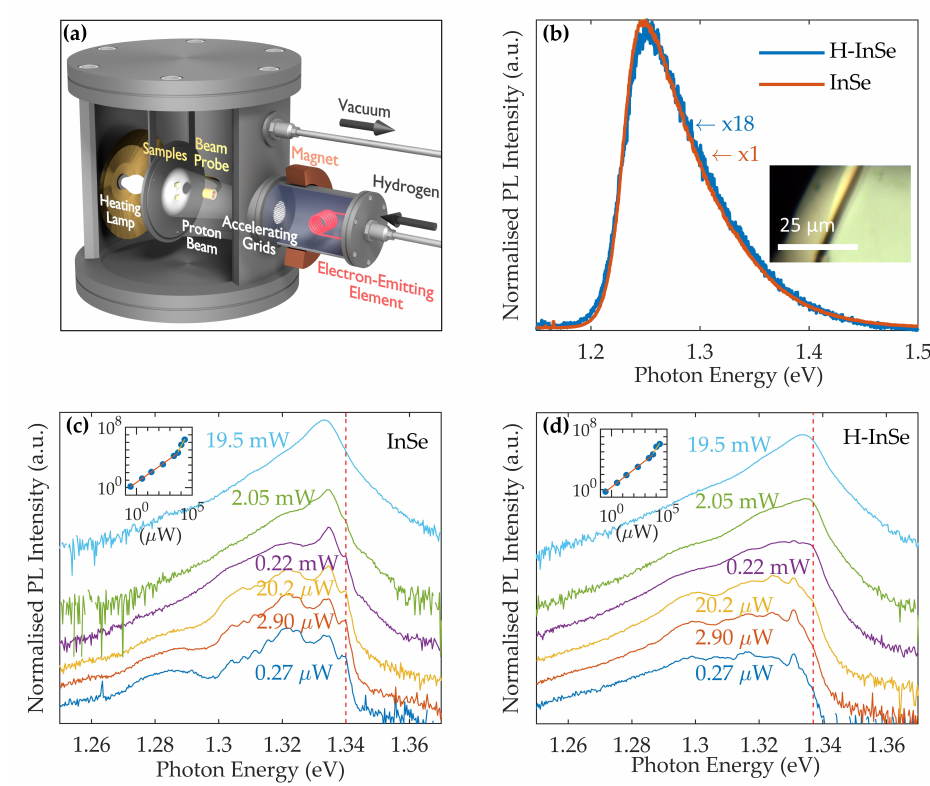
Figure 2. ( a )SchematicoftheKaufmanionsourceforincorporationofhydrogeninto γ -InSe. ( b )Normalised photoluminesence (PL) spectra measured in masked and hydrogenated (32 eV) γ -InSe, 12 days after hydrogenation ( λ = 532 nm, P = 0.2 mW, T = 300 K). Inset: optical microscopy image of the surface of hydrogenated (32 eV) γ -InSe. ( c , d ) PL spectra measured at different exciting laser powers in pristine and hydrogenated (10 eV) γ -InSe ( λ = 532 nm, T = 10 K). The spectra are plotted on a logarithmic scale with the dashed lines denoting the energy position of the exciton line (X). Insets: dependence of the total integrated PL signal on excitation power (P) on a logarithmic